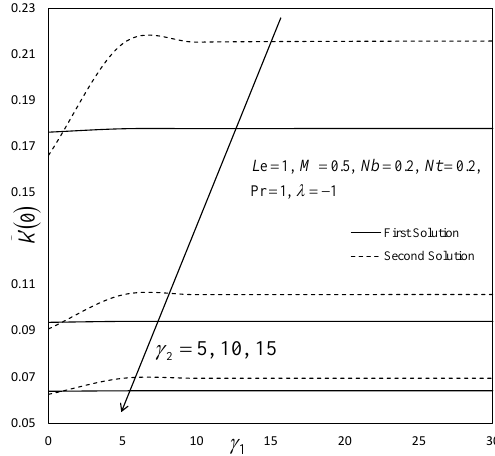
Figure 12. Variations of k (cid:48) ( 0 ) towards γ 1 for selected values of γ 2 .